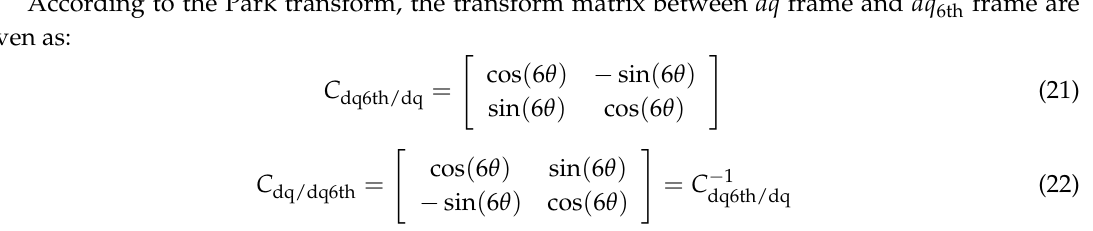
Figure 10. Three reference frames.